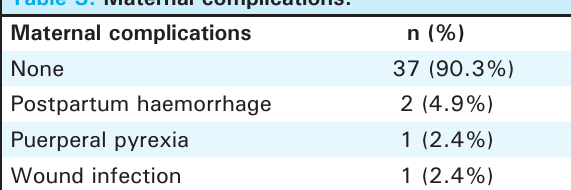
Table 3. Maternal